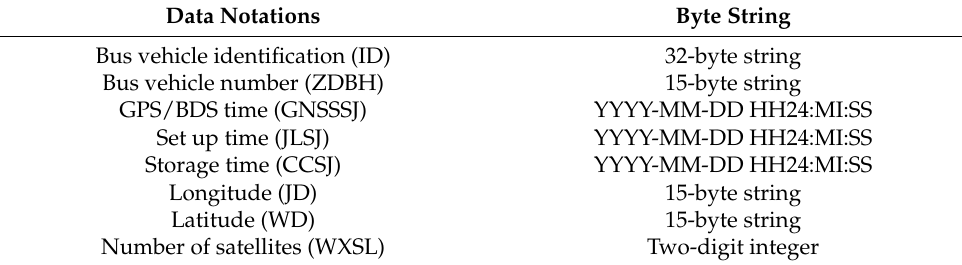
Table 3. DGNSS data format of the bus